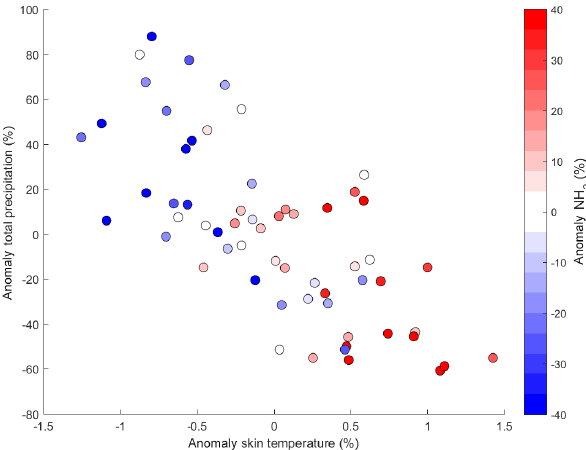
Figure 5. Scatter plot of monthly mean anomaly (relative to the 10-year monthly average from 2008 to 2017) of total precipitation versus skin temperature derived from ECMWF data from March to August in the domain and colour coded by the NH 3 total columns anomaly derived from IASI